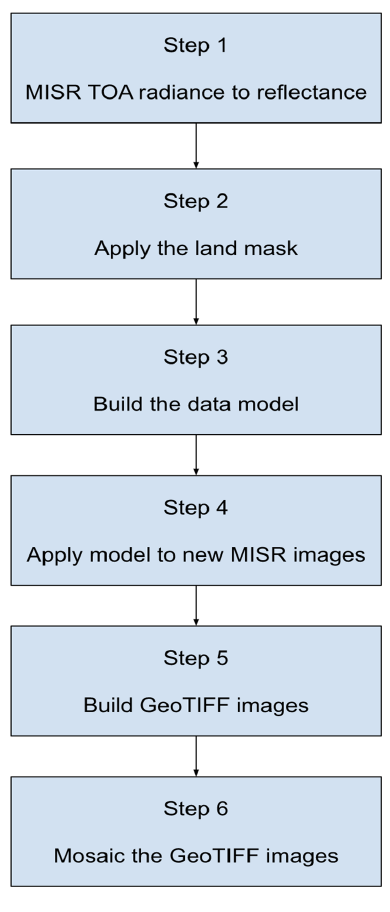
Figure 1. Data processing